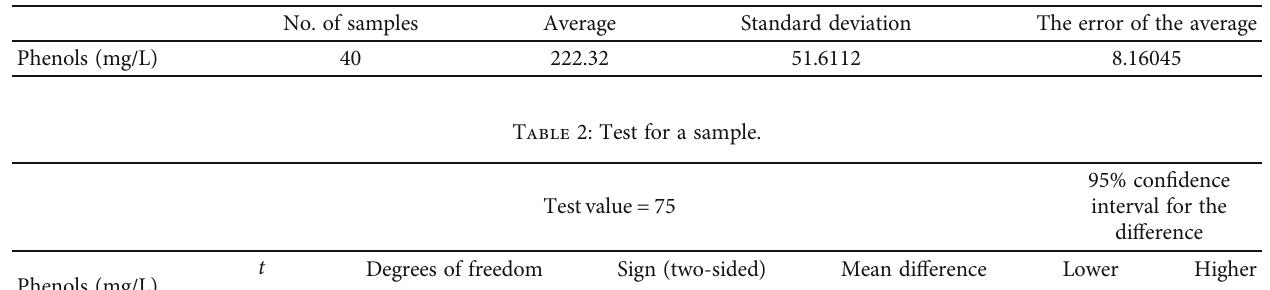
Figure 1: Calibration curve of phenols in a 525 nm spectrophotometer. Table 1: One-sample t -test